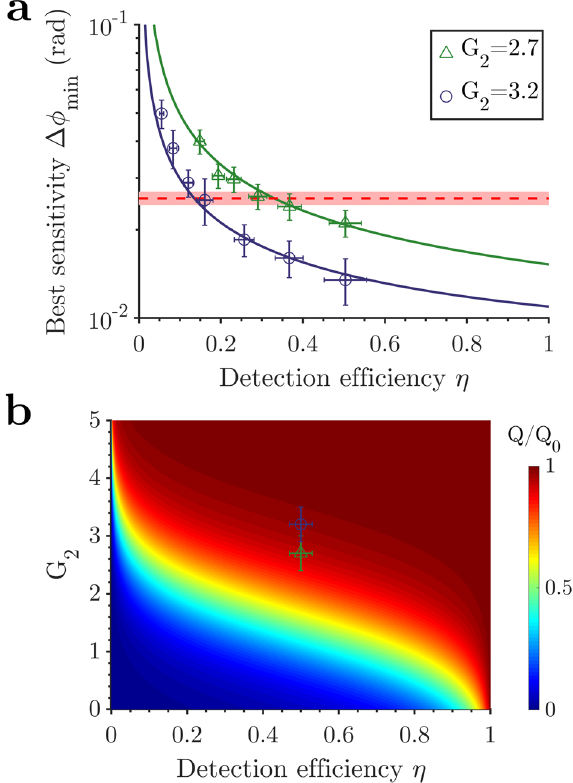
Fig. 4 Loss tolerance through phase-sensitive ampli fi cation. a Best phase sensitivity as a function of detection ef fi ciency η with G 2 = 3.2 and G 2 = 2.7 ampli fi cation (blue circles and green triangles, respectively). The SNL is the red dashed line and the lines show the theoretical model. The error bars in the vertical axis represent the standard error of the mean with a sample size of 1000 and the standard deviation for the horizontal axis. b The quantum advantage Q normalized to the ‘ perfect detection' one Q 0 = 17 versus the detection ef fi ciency and parametric ampli fi cation. Points show the experimental parameters used with standard-deviation error